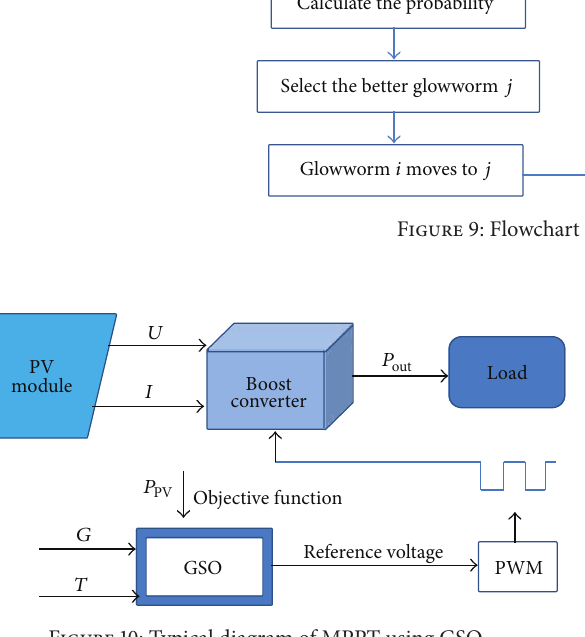
Figure 10: Typical diagram of MPPT using